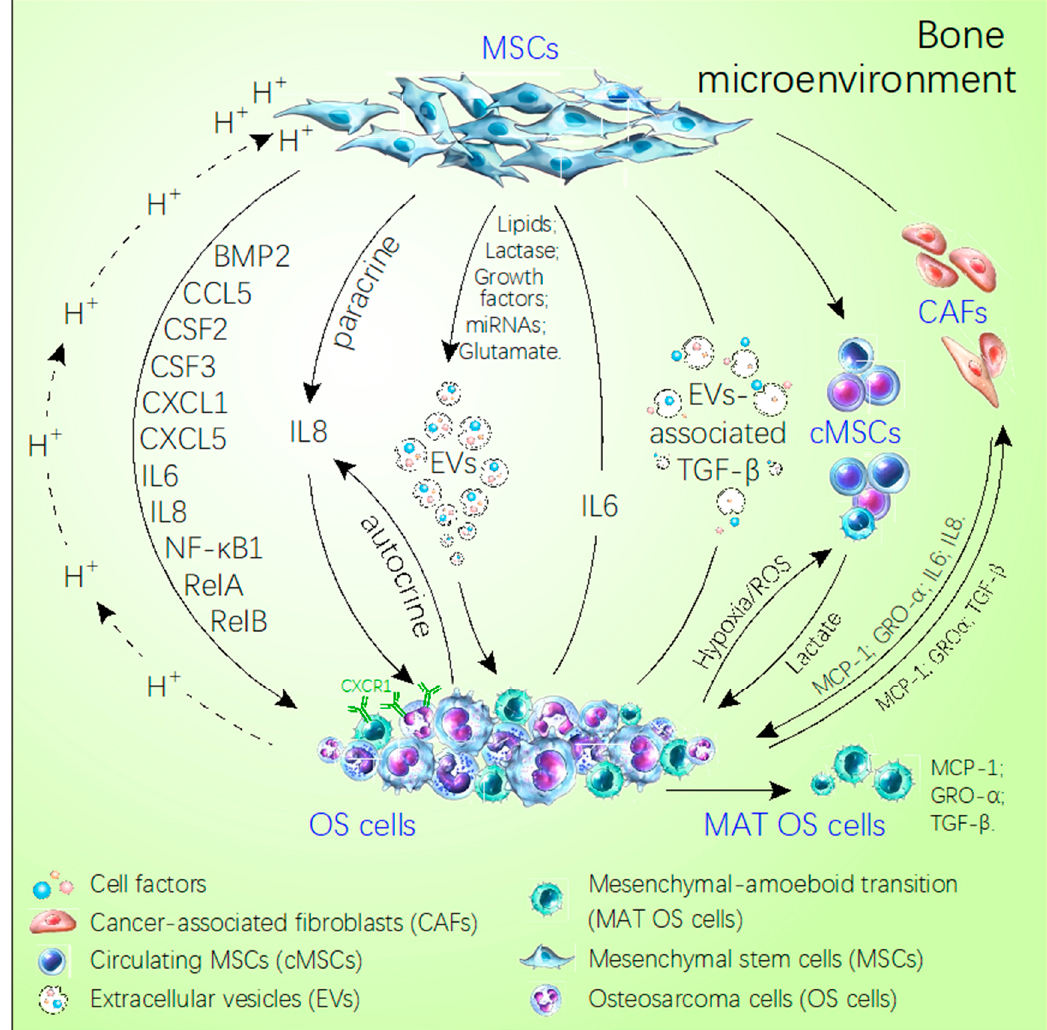
Figure 1. Schematic diagram of the cross-talk between MSCs and OS cells in the bone microenvironment. MSCs directly secrete some factors or choose the extracellular vesicles as the carrier to transport miRNAs, growth factor, lipids, glutamate, lactase, which promote OS metastasis. Meanwhile, OS utilizes the acidic environment, hypoxia and extracellular vesicles inducing the MSCs secreting cell factors to facilitate their own growth and metastasis, like IL-8, IL-6, RelA, RelB, NF- κ B1, CSF2/GM-CSF, CSF3/G-CSF, BMP2, CCL5, CXCL5, CXCL1. In addition, OS via secreted MCP-1, GRO- α , and TGF- β induces MSCs trans-differentiating the cancer-associated stem cells to express more MCP-1. GRO- α , IL-6, and IL-8 promote the MAT of OS. The solid arrows refer to the direction of the cell or factor from the MSCs. The dotted arrows refer to the direction of cells and factors from OS.